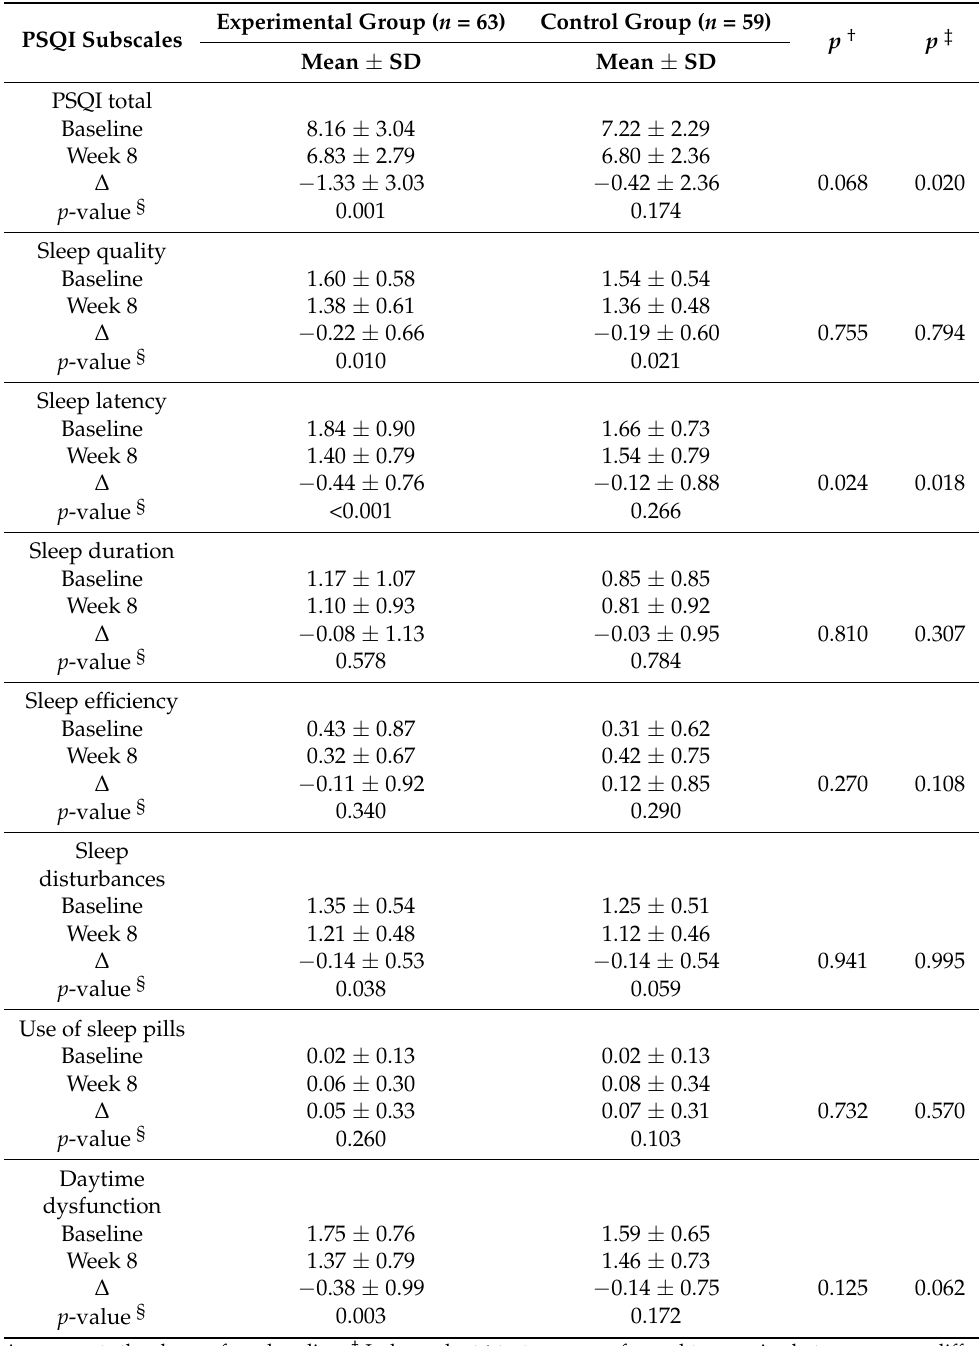
Table 4. Comparison of the changes in PSQI total and subscale scores from baseline to eight weeks of intervention between the two study